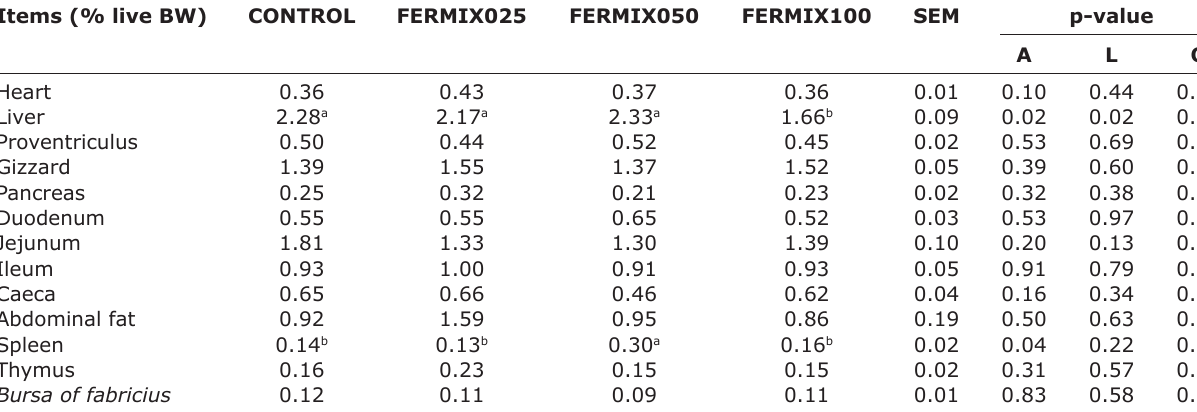
Table-3: Internal organ relative weights of broiler chickens. Items (% live BW)